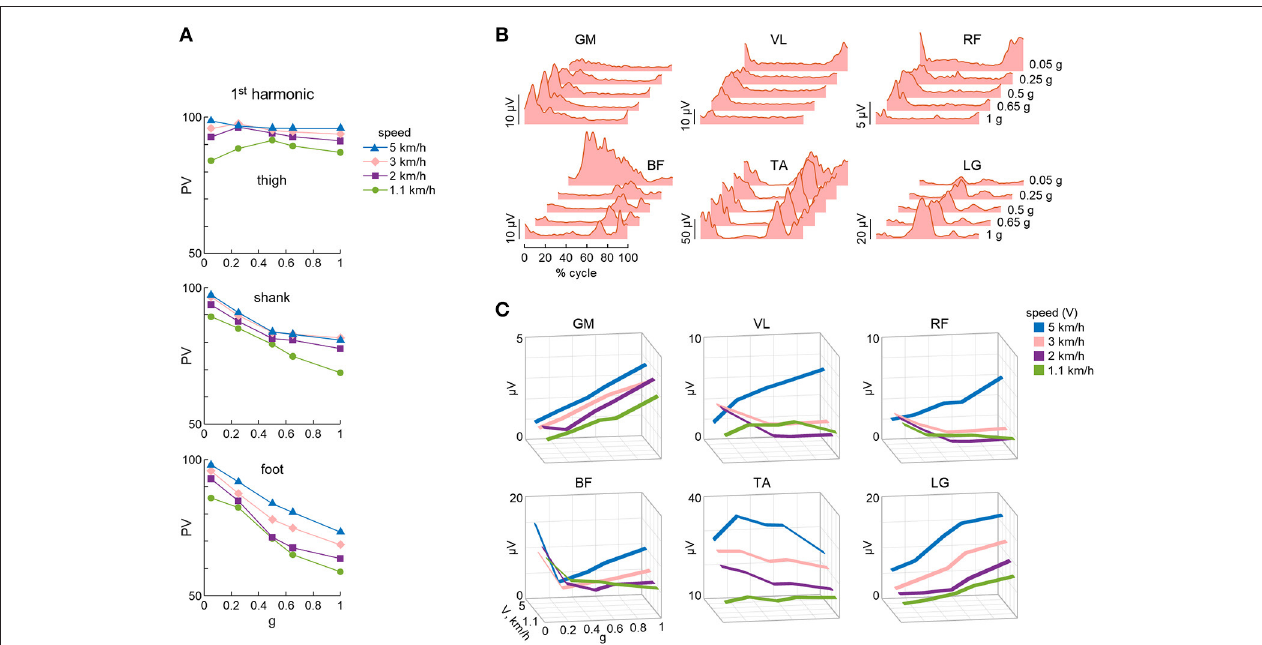
FIGURE 6 | Non-linear changes of kinematic and muscle activity patterns. (A) Percent variance (PV) (mean values over all trials and subjects) accounted for by the 1st harmonic of each elevation angle (see Figure 4A ) as a function of BWS. (B) EMG activity of lower limb muscles for a participant walking at 3 km/h at different simulated reduced gravity levels. (C) Mean EMG activity computed over the gait cycle and averaged across all subjects ( n = 8), as a function of speed and simulated reduced gravity. GM, gluteus maximus; VL, vastus lateralis; RF, rectus femoris; BF, biceps femoris; TA, tibialis anterior; LG, lateral gastrocnemius. Data are replotted from Ivanenko et al.